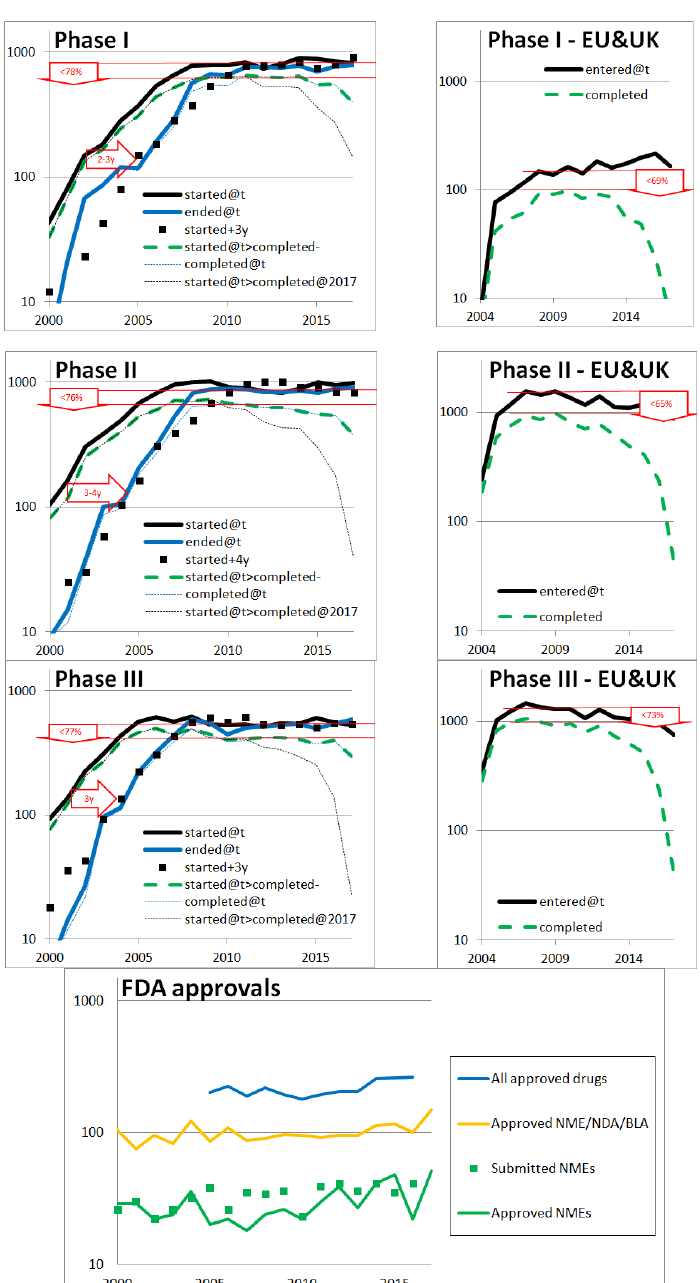
Figure A4. Pharmaceutical drug development indicators based on open data: clinicaltrials.gov, clinicaltrialsregister.eu, Drugs@FDA, and accessdata.fda.gov. The three first graphs on the left show numbers of USA clinical trials per calendar year, t, for respectively Phase I, Phase II, and Phase III